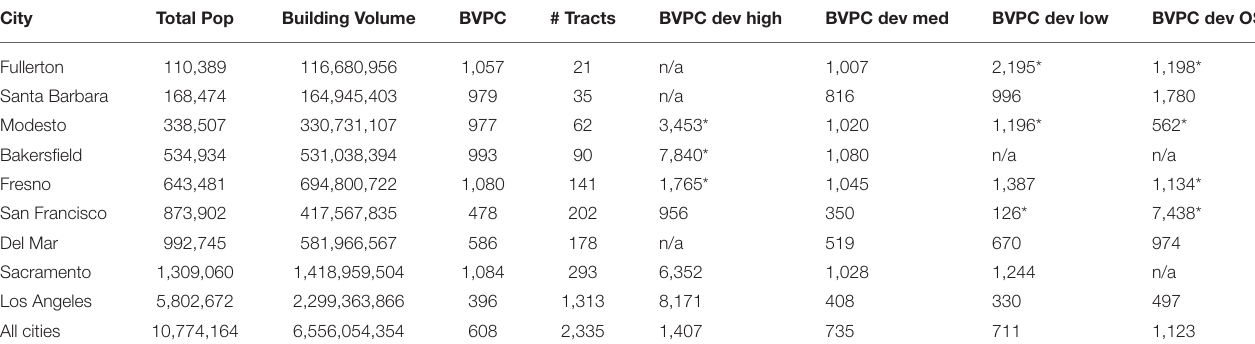
TABLE 1 | Aggregate Statistics for Census Tracts of All 9 Cities.